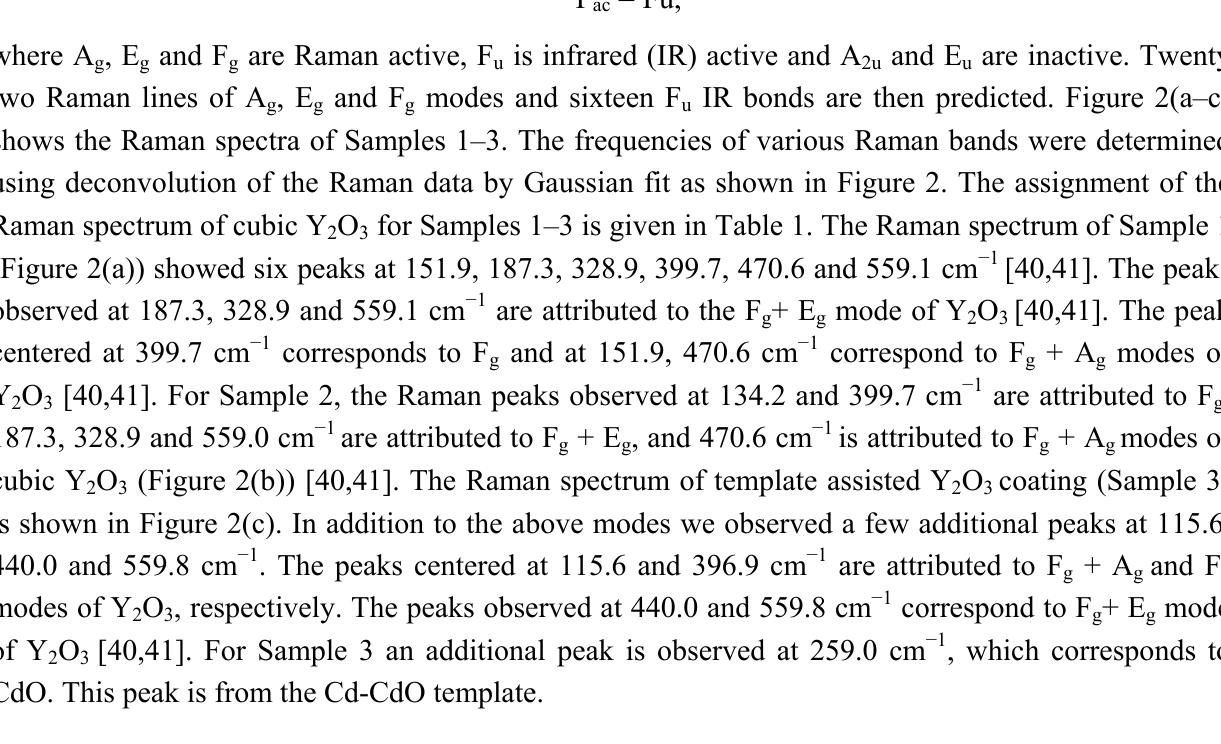
O coating, and ( c ) template assisted Y 2 3